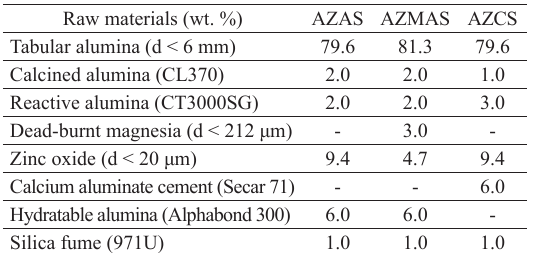
Table 1. General aspects of the castables evaluated in this work.